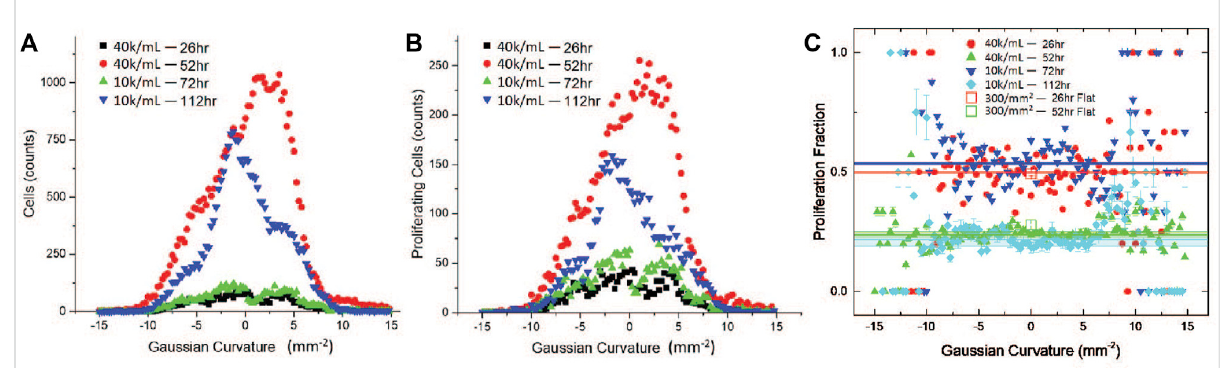
FIGURE 7 Proliferationasafunctionofcurvature. (A) NumberofcellsasafunctionofGaussiancurvatureontoroidalgels. (B) Numberofproliferatingcells as a function of Gaussian curvature on toroidal gels. (C) Proliferation fraction as a function of Gaussian curvature on toroidal and planar gel surfaces. Solid symbols are toroidal gel data and open symbols are planar gel data. The horizontal lines are averages over all Gaussian curvature ranges for toroidal data, with standard errors estimated from the background ±